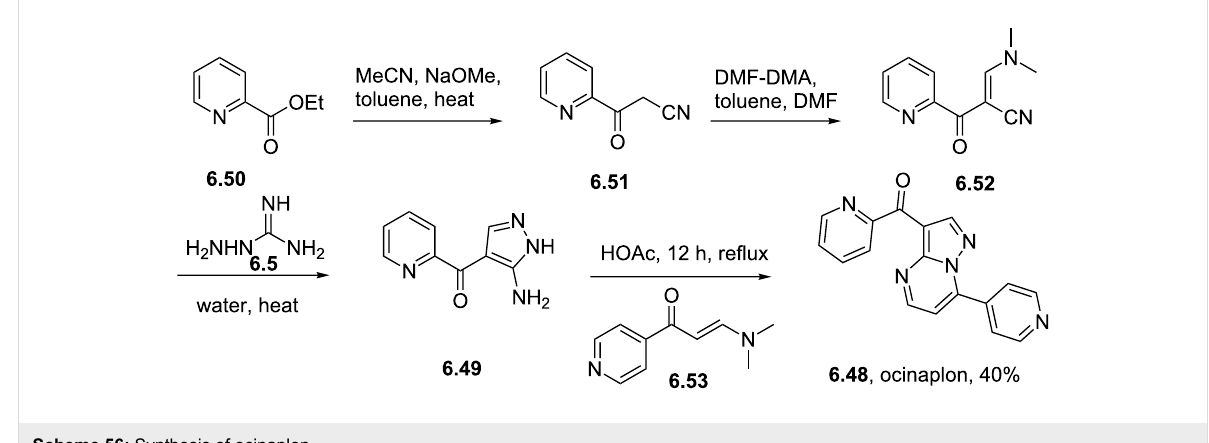
Scheme 56: Synthesis of ocinaplon.